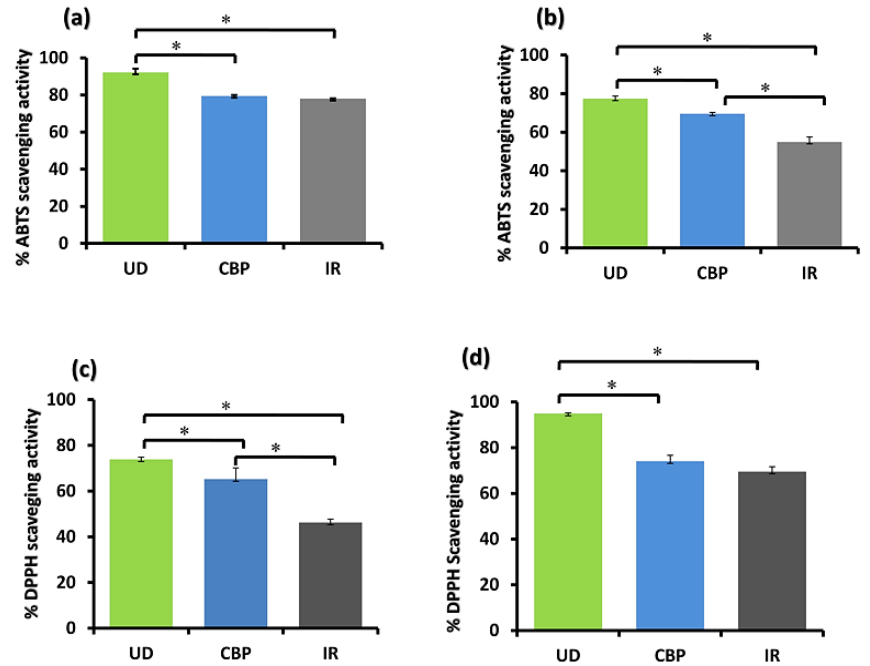
Figure 2. Comparative ABTS and DPPH radical scavenging activity of aqueous ( a , c ) and ethanolic extracts ( b , d ) of the leaves of Urtica dioica (UD), whole plant of Capsella bursa-pastoris (CBP), and rhizomes of Inula racemosa (IR) at a concentration of 2 mg/mL for DPPH (both AQ and Eth) and ABTS concentration used was 2 mg/mL (AQ) and 0.2 mg/mL (ETH). Data are shown as the mean ± SD for n = 3. * p < 0.05 was considered statistically